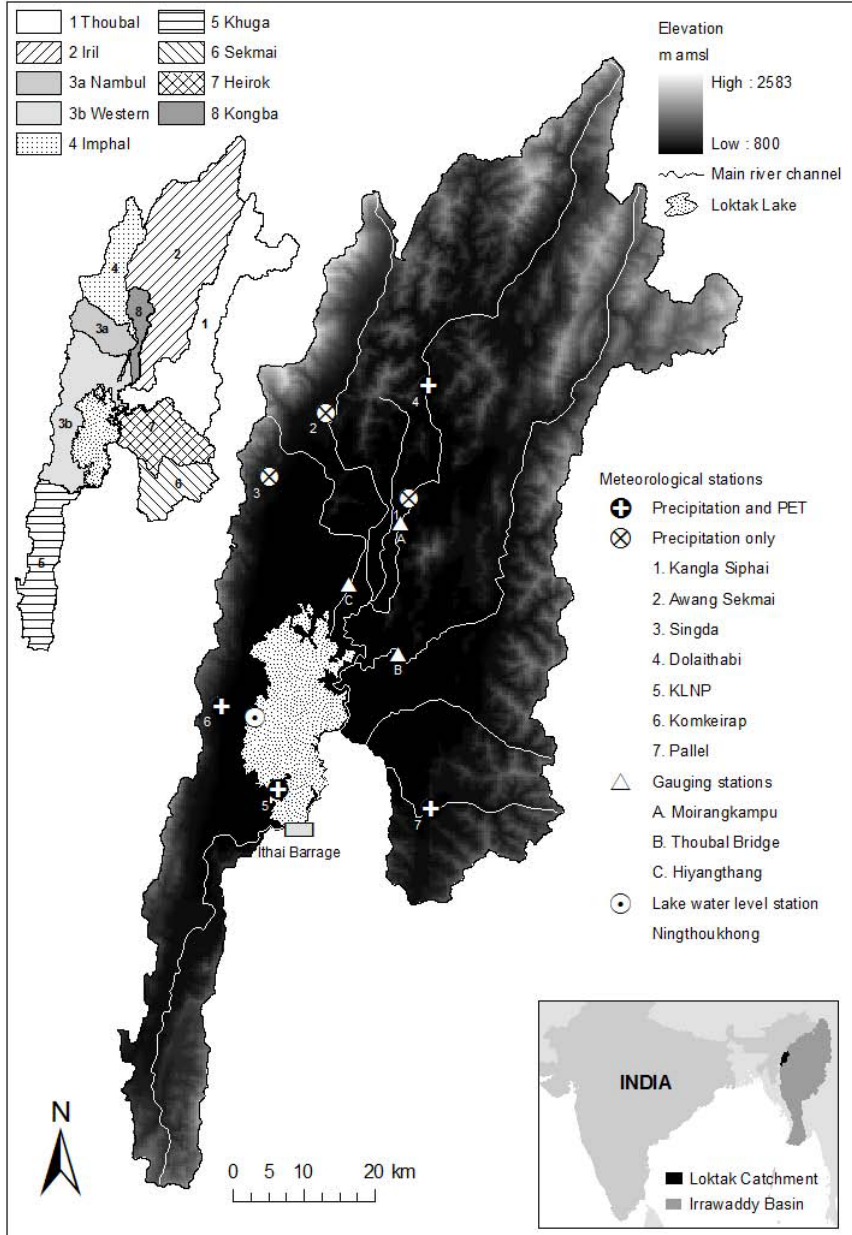
Fig. 1. Loktak Lake, its sub-catchments and location of hydrometeorological stations (Irrawaddy Basin outline from GRDC grdc.bafg.de).